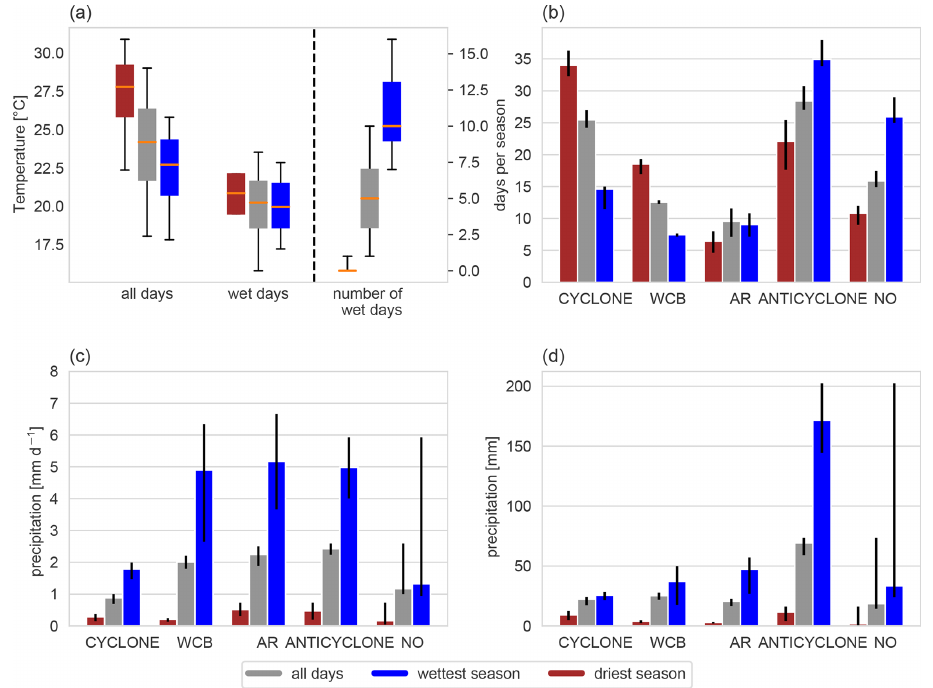
Figure 12. Same as Fig. 9 but for summer in